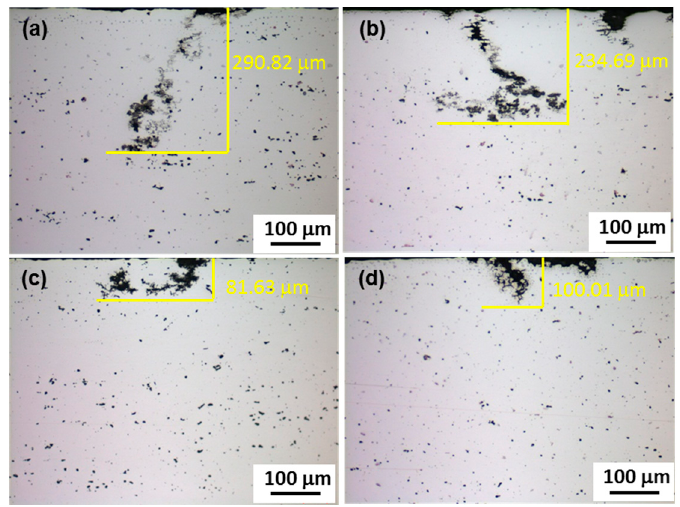
Figure 6. The maximum depth of attack on the experimental alloy in the IGC test for 24 h: ( a ) Ce-free alloy at T6 temper; ( b ) Ce-containing alloy at T6 temper; ( c ) Ce-containing alloy at T7 temper; ( d ) Ce-containing alloy at RRA temper.